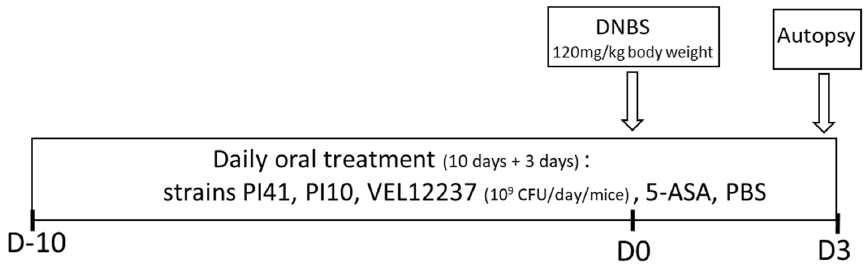
Figure 1. DNBS protocol. Colitis was induced by intrarectal administration of DNBS at 120 mg/kg of body weight solubilized in 30% ethanol (EtOH) in PBS. Control mice (without colitis) received only 30% EtOH in PBS.